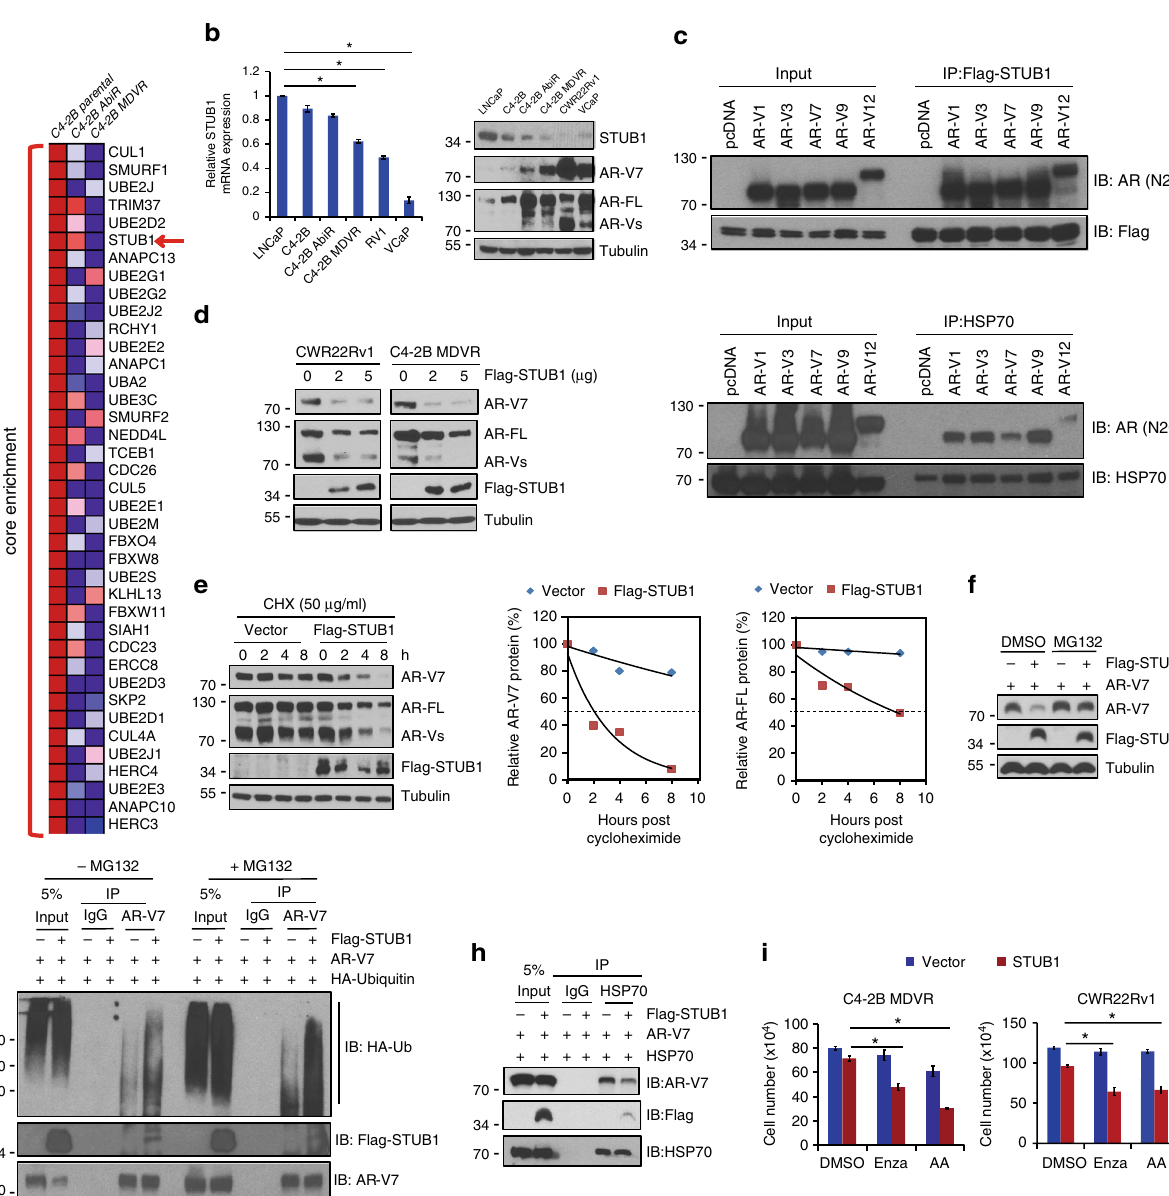
Fig. 2 STUB1/HSP70 complex regulates AR variants protein expression. a Core-enrichment genes of ubiquitin-mediated proteolysis pathway in C4-2B parental, C4-2B MDVR, and C4-2B AbiR cells. The red arrow showed STUB1 was suppressed in resistant cells. b mRNA levels of STUB1 in LNCaP, C4-2B parental, C4-2B AbiR, C4-2B MDVR, CWR22Rv1, and VCaP cells was examined by real-time PCR (left). Protein expression of STUB1, AR-V7, AR-FL was determined by western blot (right). c 293 cells were transiently transfected with Flag-STUB1 or HSP70 with or without vector, AR-V1, AR-V3, AR-V7, AR- V9, or AR-V12 for 3 days and whole cell lysates were immunopreciptated with anti-Flag or HSP70 antibodies and bloted with indicated antibodies. d CWR22Rv1 and C4-2B MDVR cells were transiently transfected with 2 or 5 µ g Flag-STUB1 for 3 days, whole cell lysates were collected and subjected to western blot. e CWR22Rv1 cells were transiently transfected with vector or fl ag-STUB1 and then treated with 50 µ g/mL cycloheximide, total cell lysates were collected at 0, 2, 4, and 8 h after the treatment and subjected to western blot. Half-lives of AR-V7 and AR-FL were calculated. f 293 cells were transiently transfected with AR-V7 with or without STUB1 for 3 days and then treated with 5 µ M MG132 overnight. Total cell lysates were collected and subjected to western blot. g 293 cells were transiently transfected with AR-V7, fl ag-STUB1, and HA-ubiquitin plasmids for 3 days, following treatment with or without 5 µ M MG132 for additional 6 h. Total cell lysates were collected and immunopreciptated with AR-V7 antibody and blotted with indicated antibodies. h 293 cells were co-transfected with HSP70, AR-V7 with or without Flag-STUB1 for 3 days and then whole cell lysates were immunopreciptated with anti-HSP70 antibody and blotted with indicated antibodies. i C4-2B MDVR or CWR22Rv1 cells were transiently transfected with STUB1 and then treated with 20 μ M enzalutamide or 5 μ M abiraterone for 3 days and total cell number was determined. * p < 0.05. Results are the mean of three independent experiments (±s.d.). Statistical analysis was performed using one-way ANOVA. AR-FL: full-length AR, AR-Vs: AR-Variants, Ub: